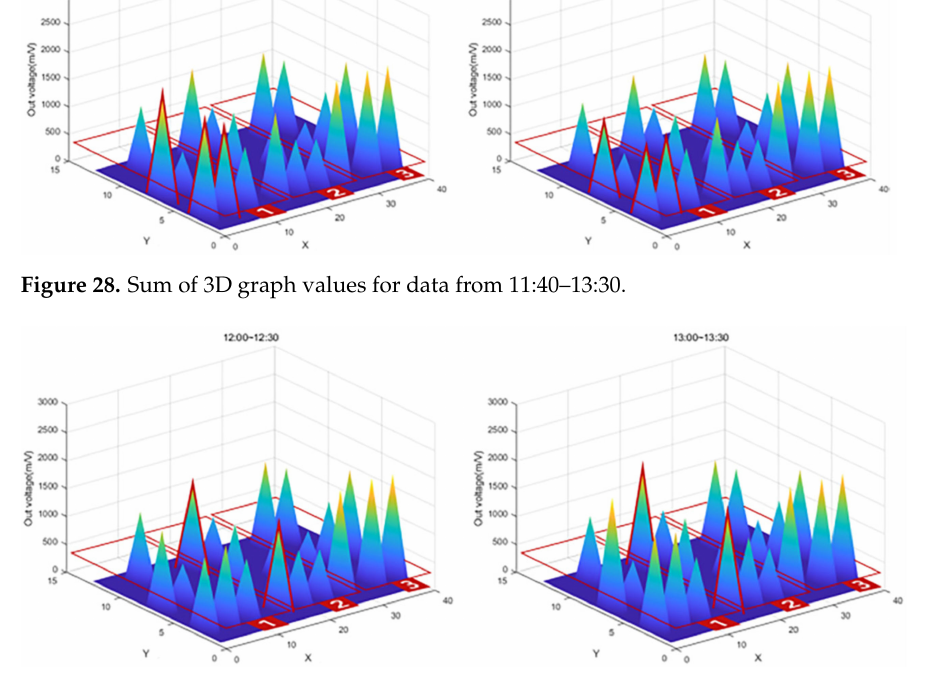
Figure 29. Sum of 3D graph values for data from 12:00–13:30.